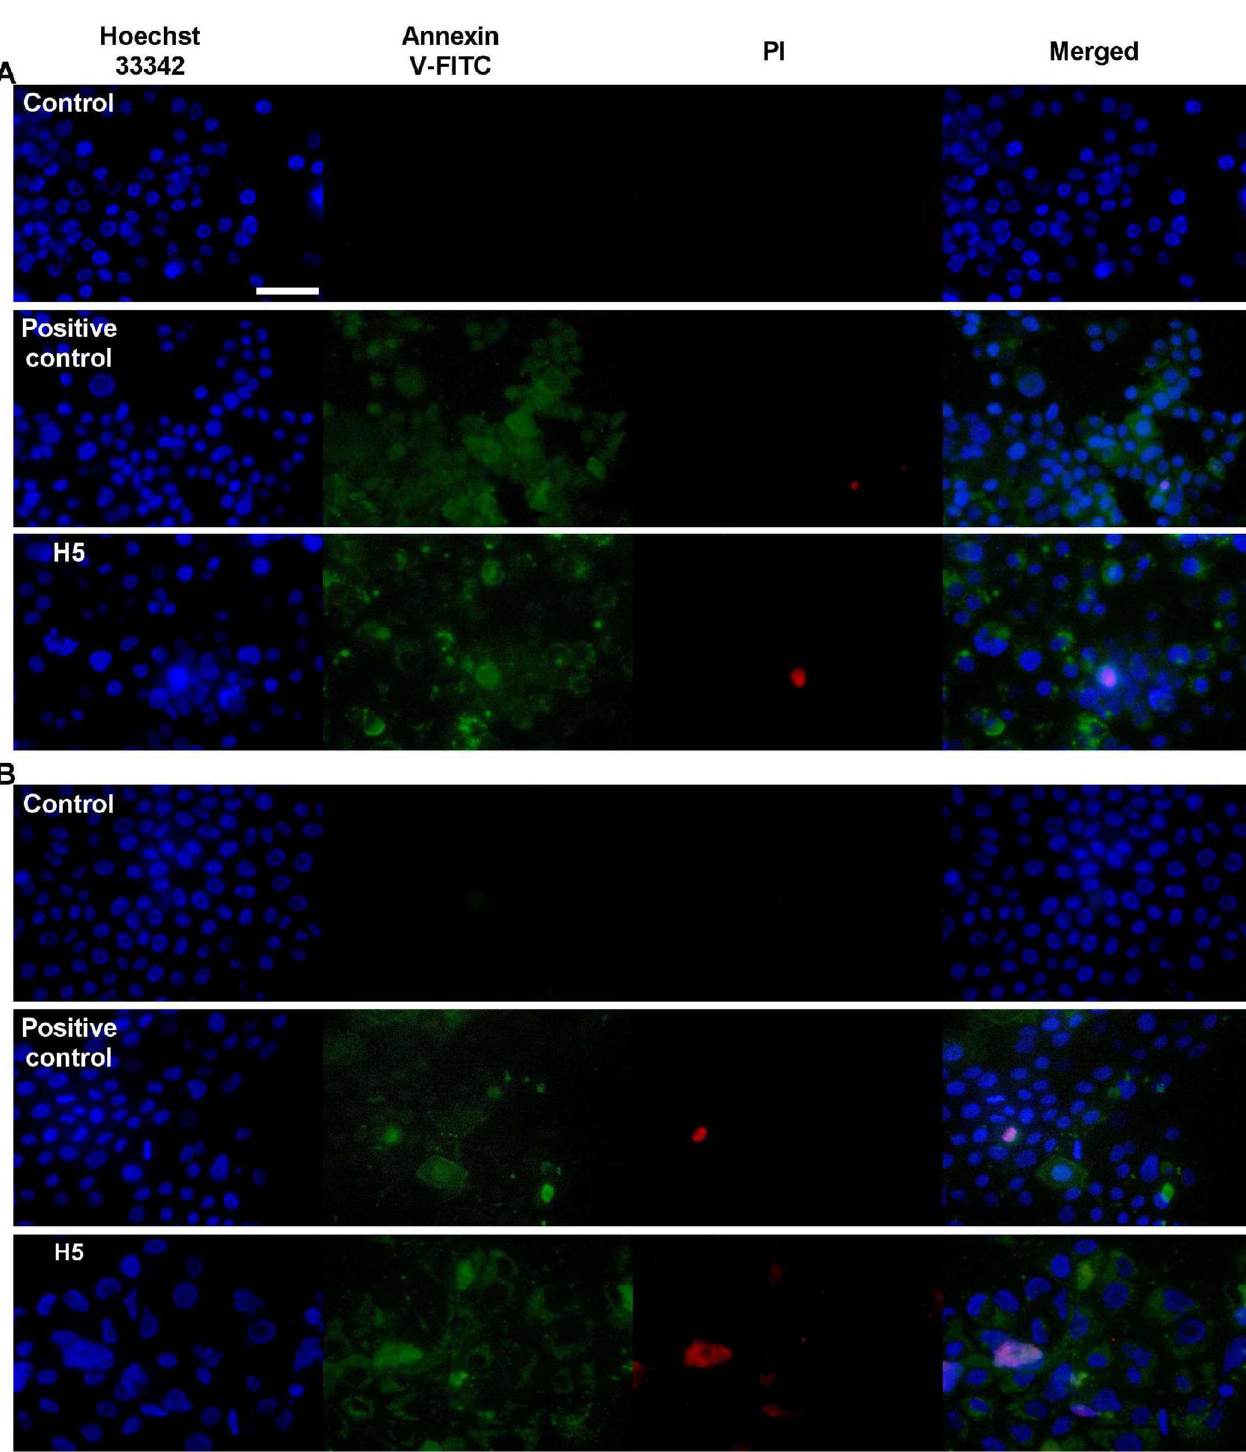
Fig 9. Detection of apoptotic cells using annexin V-FITC and PI double-staining. AsPC-1 cells (A) and BxPC-3 cells (B) were treated with curcumin in the H5 formulation at a concentration equivalentto the IC50 of curcumin for 72 hours. Early (annexin V-FITC staining)and late (PI staining)apoptotic stages are shown. Scale bar represents 50 μ